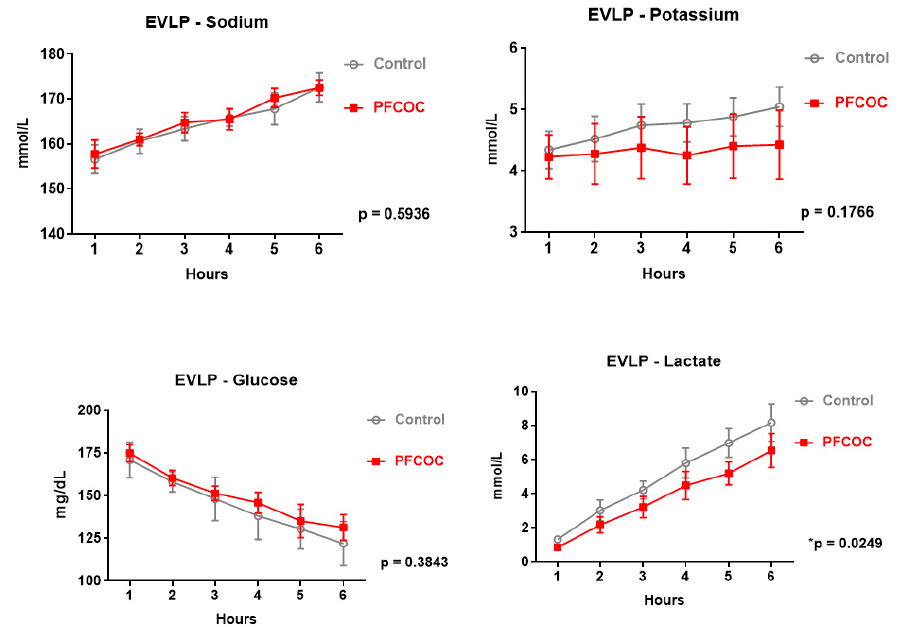
Figure 3. Perfusate electrolytes, glucose and lactate levels in both groups throughout the EVLP. Two-way analysis of variance (ANOVA) for repeated measures. Control: control group, PFCOC: perfluorocarbon-based oxygen carrier group.